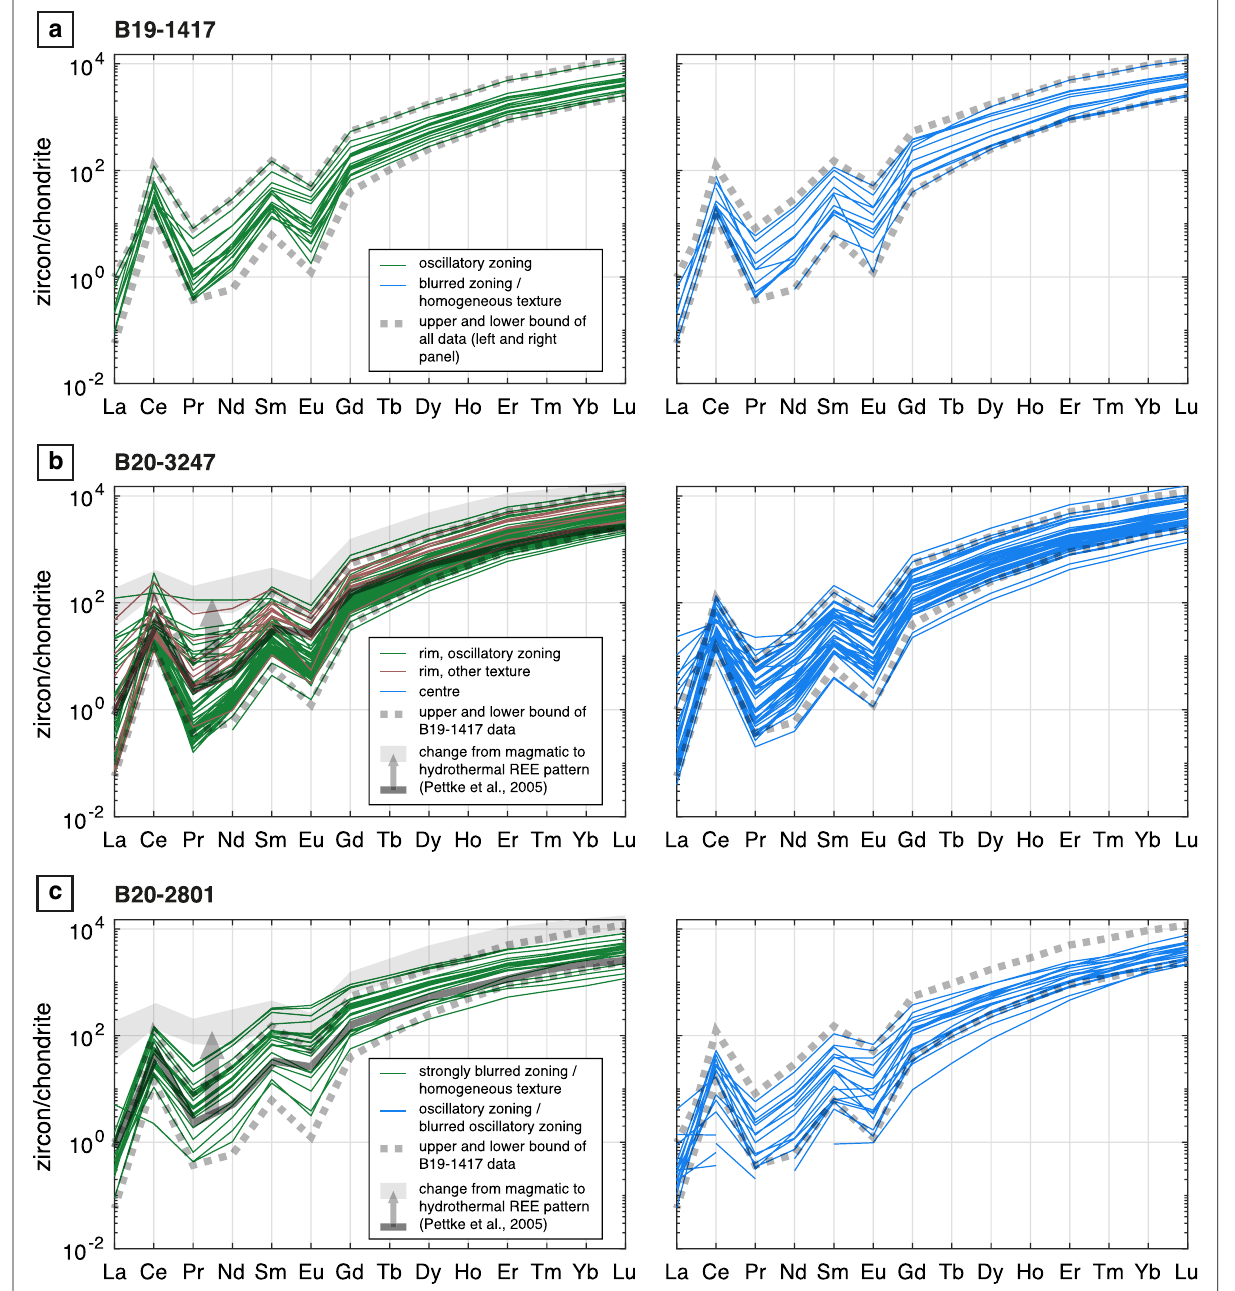
Fig. 13 Trace element composition of zircons (chondrite-noramlized after Sun and McDonough, 1989). Dashed gray lines represent the upper and lower bounds of the data from sample B19-1417 and are shown for comparison. The solid gray lines and areas represent the change from a magmatic to a hydrothermal REE pattern after Pettke et al. (2005). Note that the left and right fields each belong to the same sample. a RG1 (sample B19-1417), b RG2 (sample B20-3247), c QB-SZ (sample